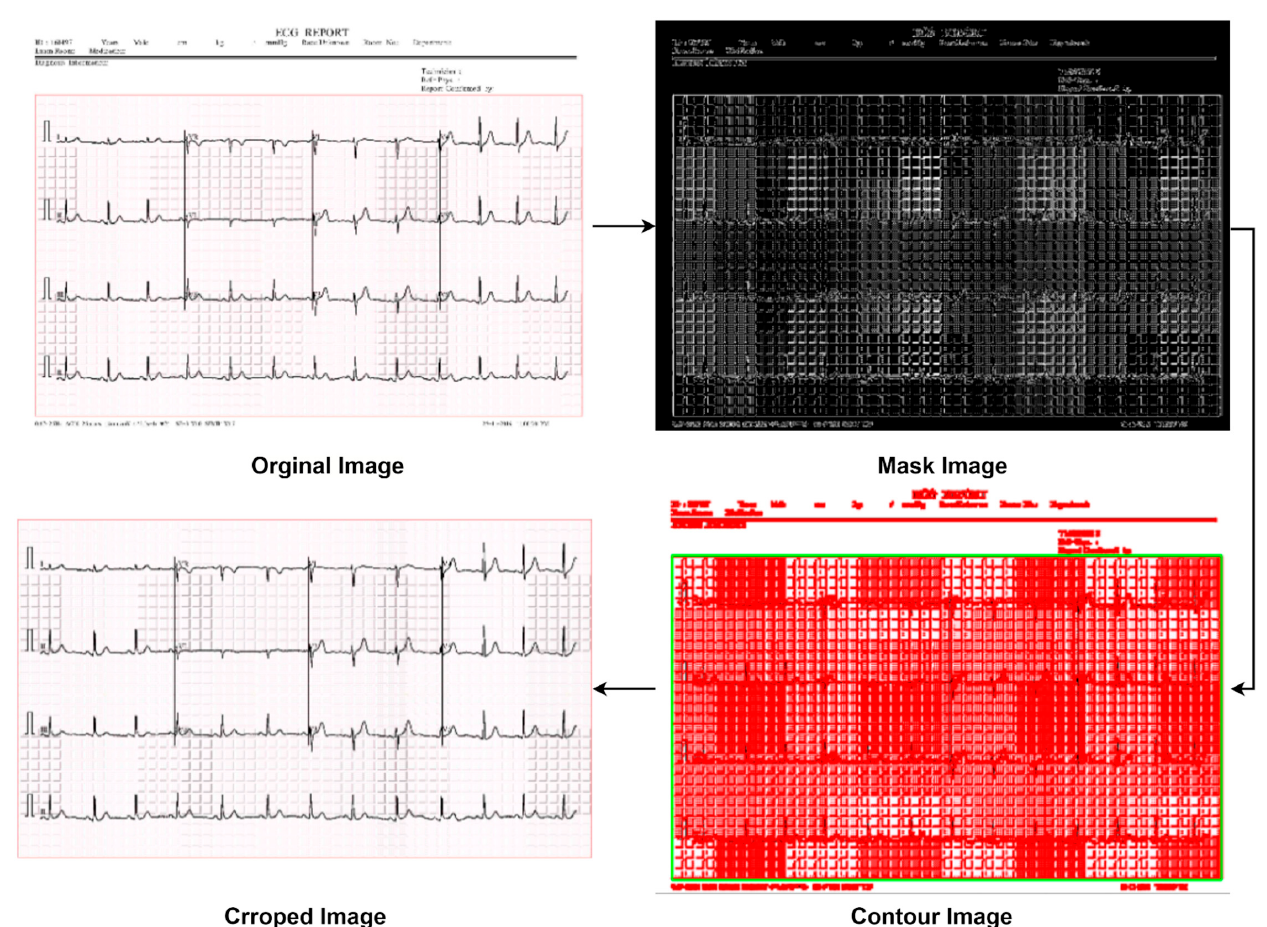
Figure 5. Label removal method. Graph Line Removal